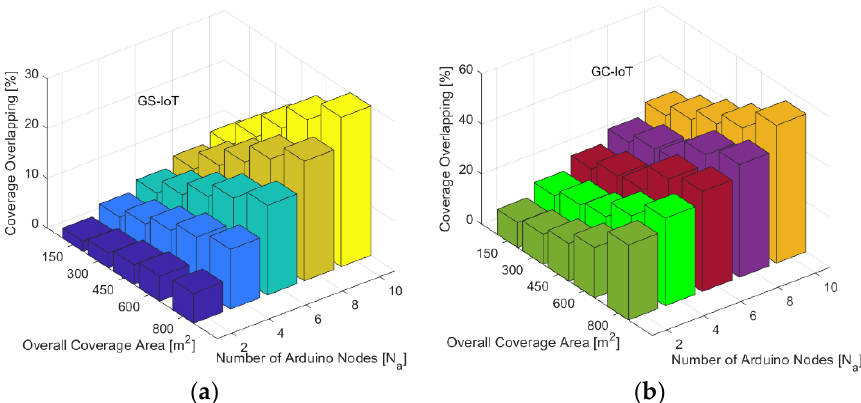
Figure 18. Hardware node-based coverage overlapping comparison ( a ) GS-IoT; ( b ) GC-IoT.